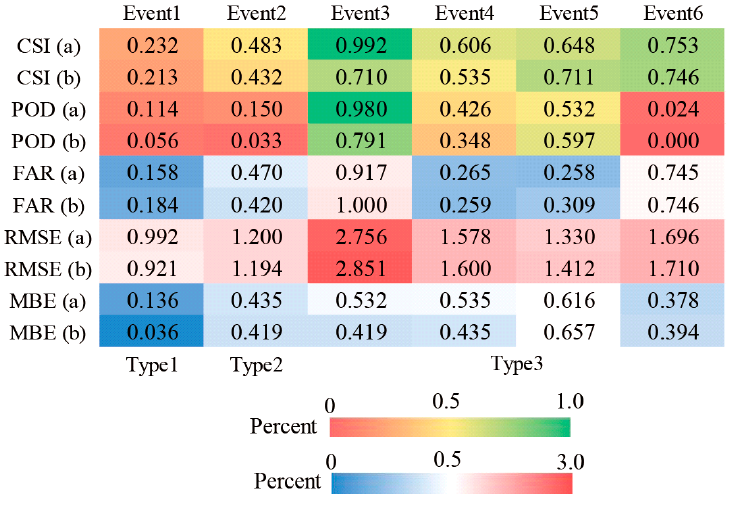
Figure 4. Temporal heat map of the indices error: ( a ) WRF-only; ( b ) the fully coupled WRF/WRF-